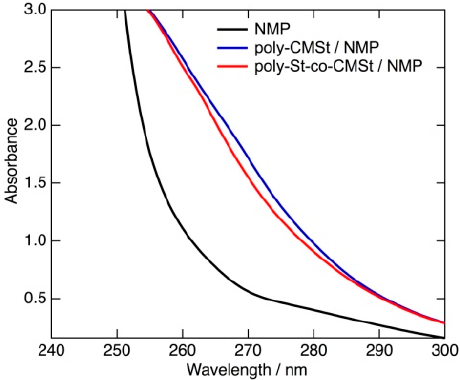
Figure 9. UV absorption spectra of solvent (NMP) and polymer/NMP solutions.